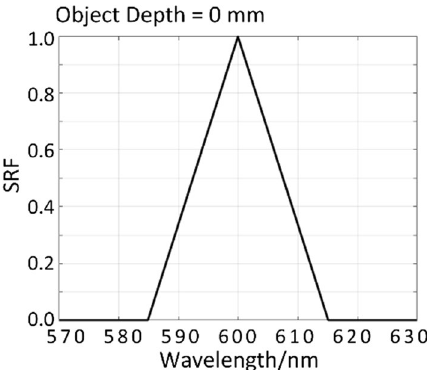
Fig.11 The theoretical curve of SRF with object depth 0 mm